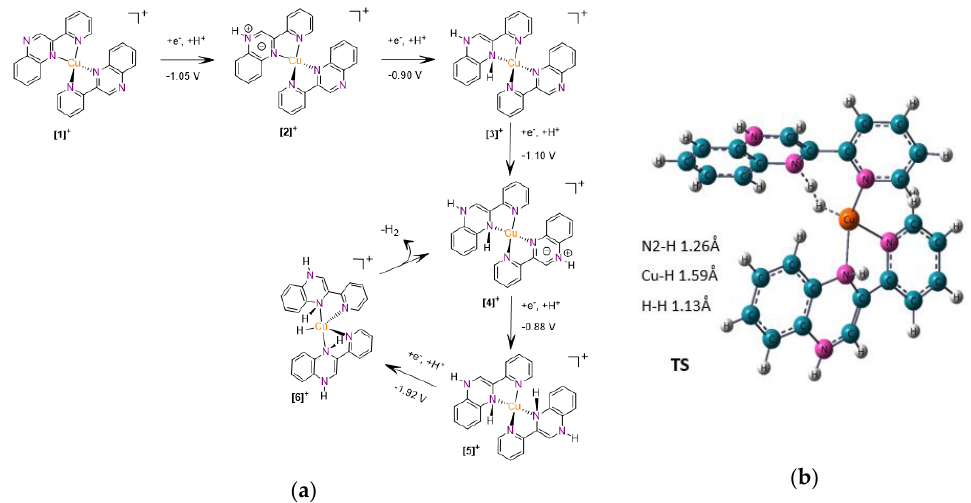
Figure 6. ( a ) Proposed mechanism for the electrocatalytic H 2 formation by [1] + based on DFT calculations using the B3LYP-D3/6-311+g(2d,p) method for the calculation of redox potentials and calculations using the B3LYP-D3 / 6-311 + g(2d,p) method for the calculation of redox potentials and protonation energies ( b ) Structure of the transition state (TS) for H 2 formation. protonation energies ( b ) Structure of the transition state (TS) for H 2